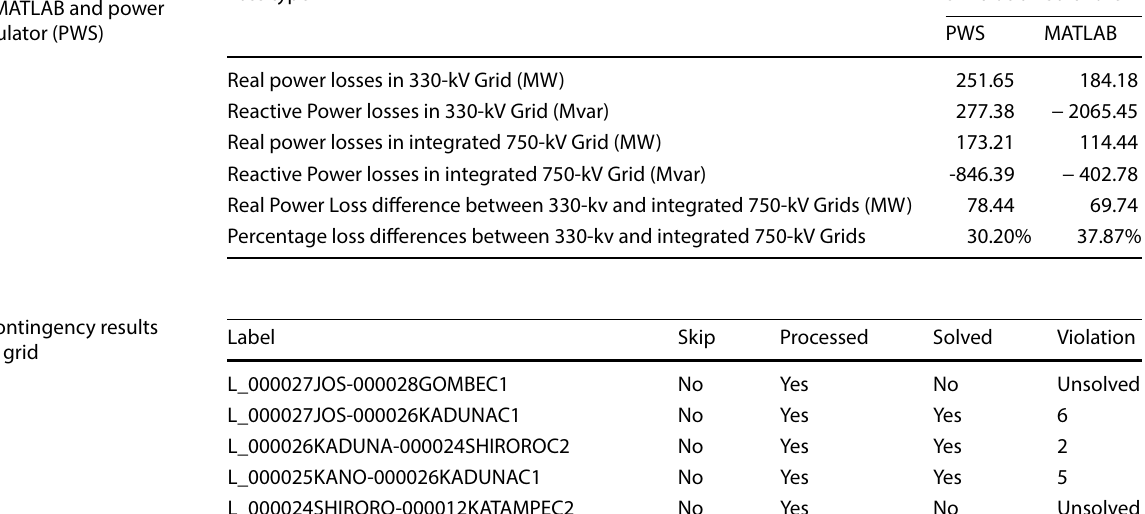
Table 3 Loss comparison between MATLAB and power world simulator (PWS)